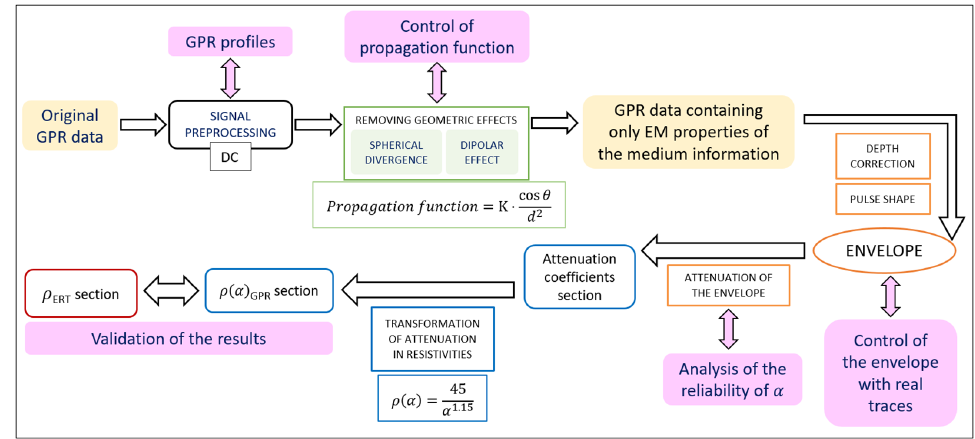
Figure 17. Flowchart with the main processing steps and variables involved in the methodology.